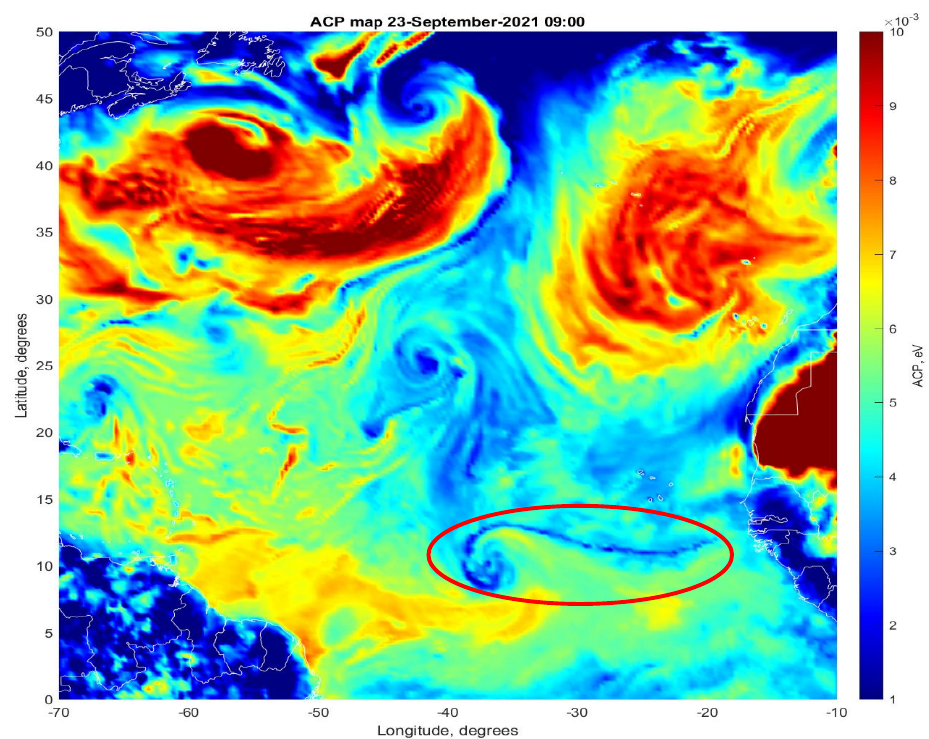
Figure 2. ACP distribution on 23 September 2021 at 09:00 UTC. The red oval shows Hurricane Sam’s position.